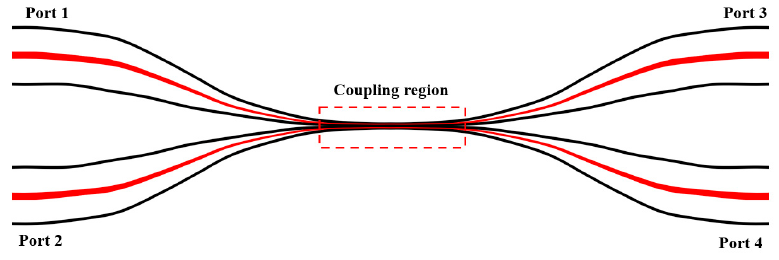
Figure 1. Schematic diagram of tapered MFC.